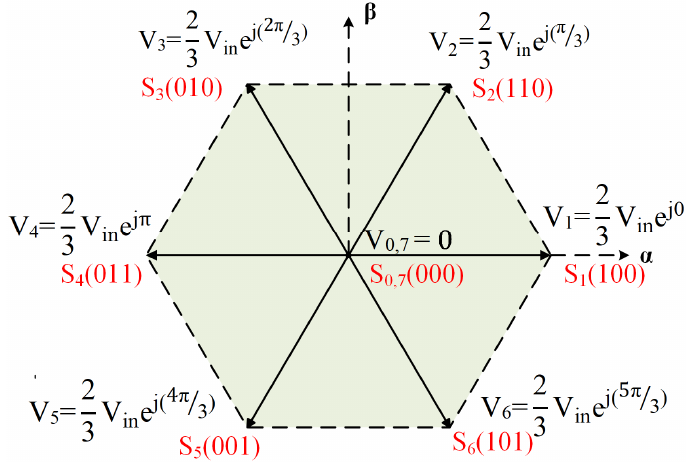
Figure 2. Switching states and voltage vectors of the three-phase